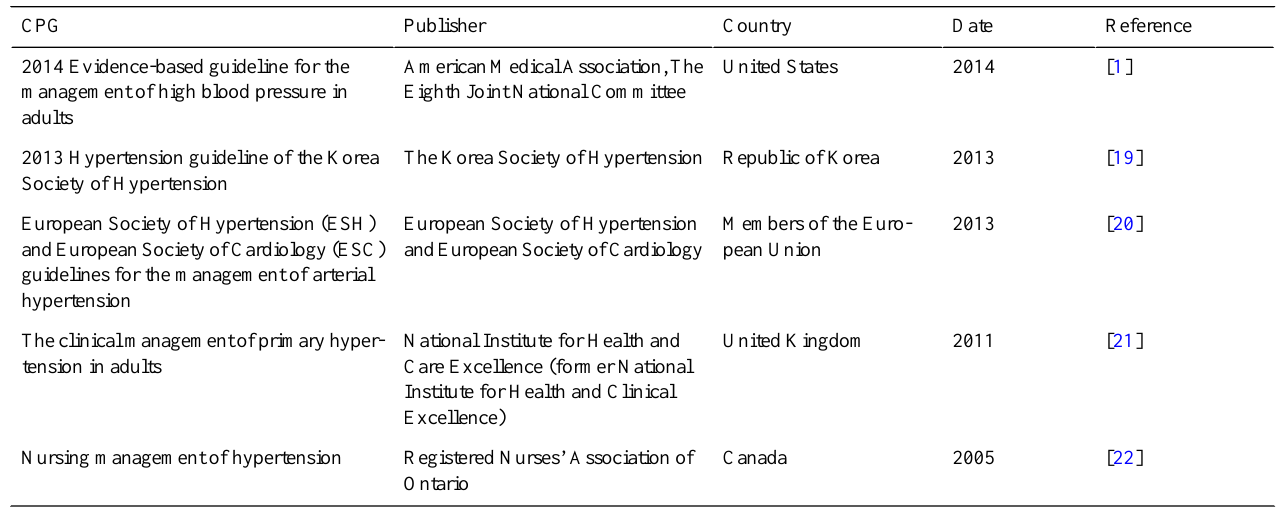
Table 1. CPGs selected for the HMA. ReferenceDateCountryPublisherCPG